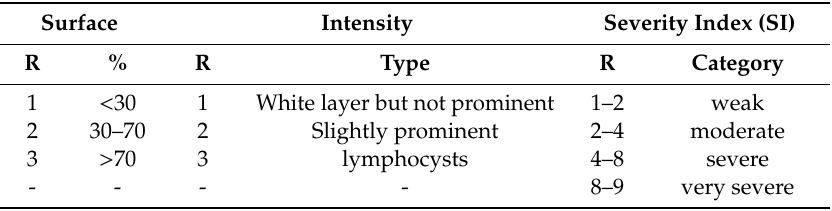
Table 2. Rates (R) for LCDV lesions according to surface covered and intensity. Categories for severity index are also